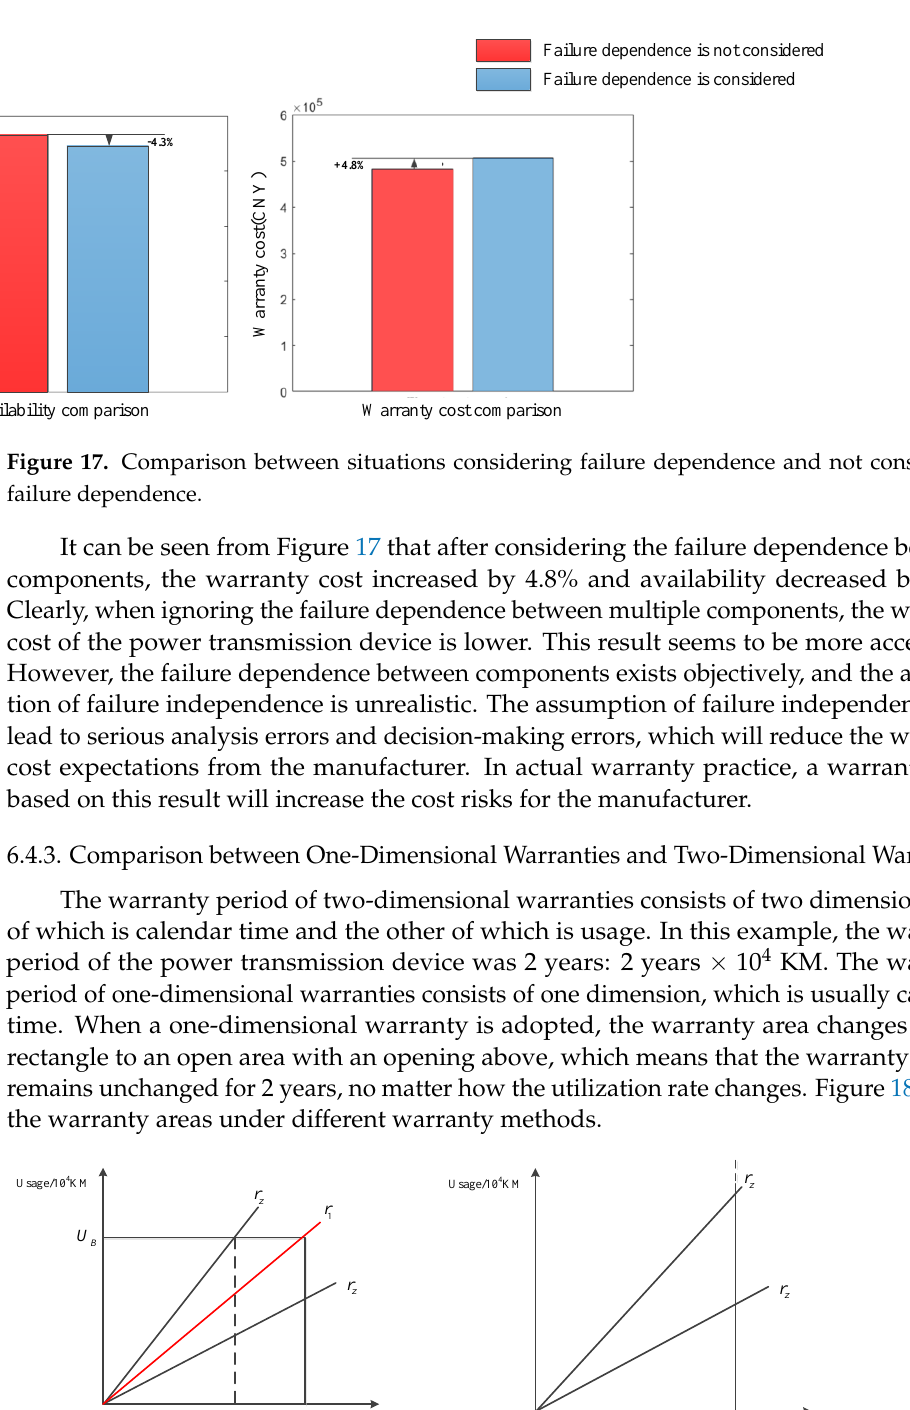
Table 10. Comparison of warranty cost and availability under different warranty methods.